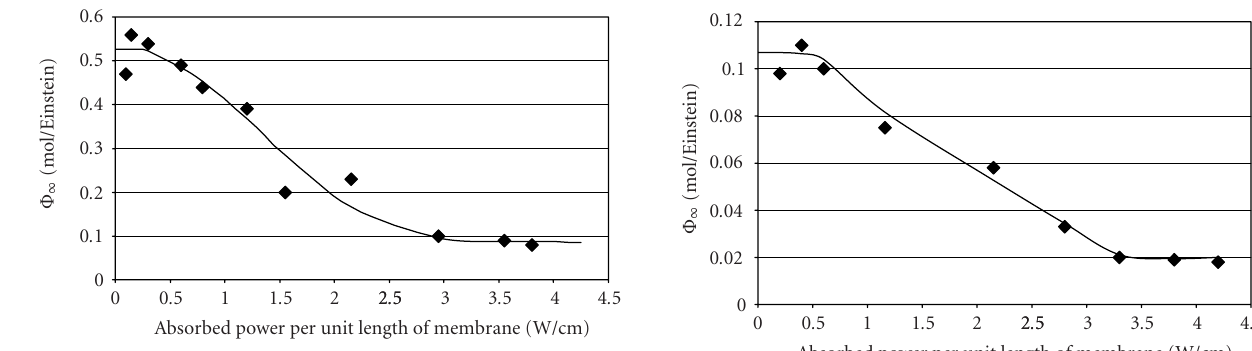
Figure 5: Quantum e ffi ciencies Φ ∞ (mol/Einstein), extrapolated by (1) (see Section 2), at “infinite” concentration of substrate for ethanoic acid in aqueous solution as a function of absorbed power per unit length of irradiated photocatalytic membrane expressed as Wcm − 1 . Data taken from